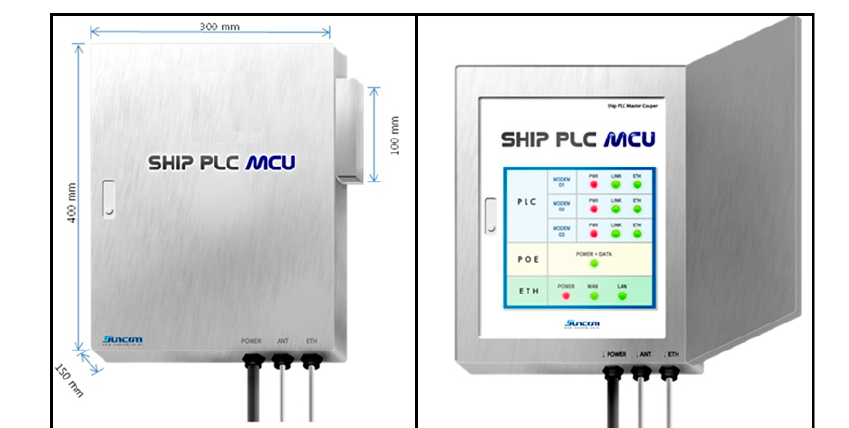
Figure 11. Prototype of the Ship-PLC MCU.